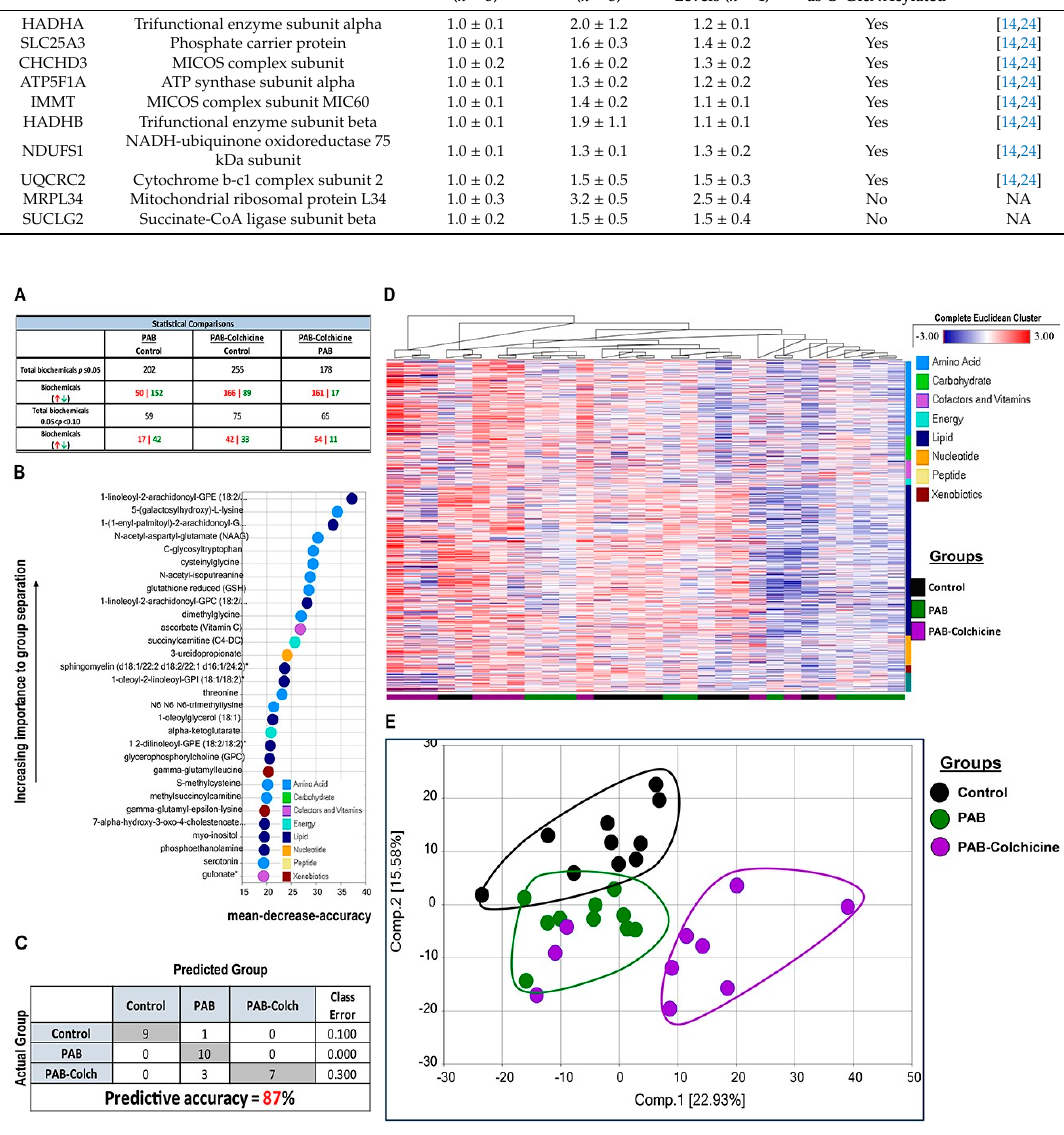
Figure 4. Effect of colchicine treatment on metabolomic signature in PAB rats. ( A ) Table depicting the overall differences in metabolites in control, PAB, and PAB-Colch right ventricles. ( B ) Biochemical importance plot revealing the top 30 ranking biochemicals that differentiates experimental groups. ( C ) Random Forest Confusion Matrix shows analysis of metabolomics data results in an 87% predictive accuracy. ( D ) Hierarchical clustering analysis of metabolites. ( E ) Principal component analysis of total metabolomic data reveals colchicine did not normalize the metabolic signature in PAB rats. Tissue was harvested 8 weeks after sham or PAB